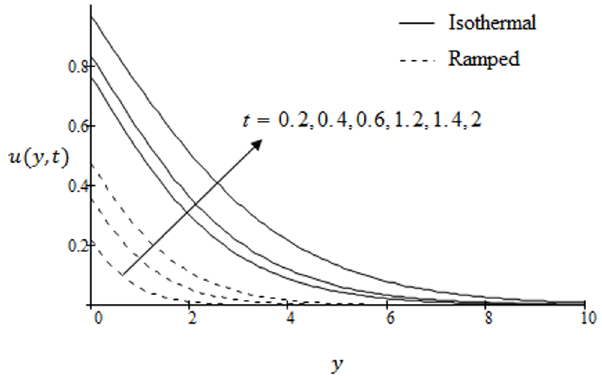
Figure 6. Velocity profiles for different values of t when the plate applies a constant shear stress f ~{ 0 : 25 .